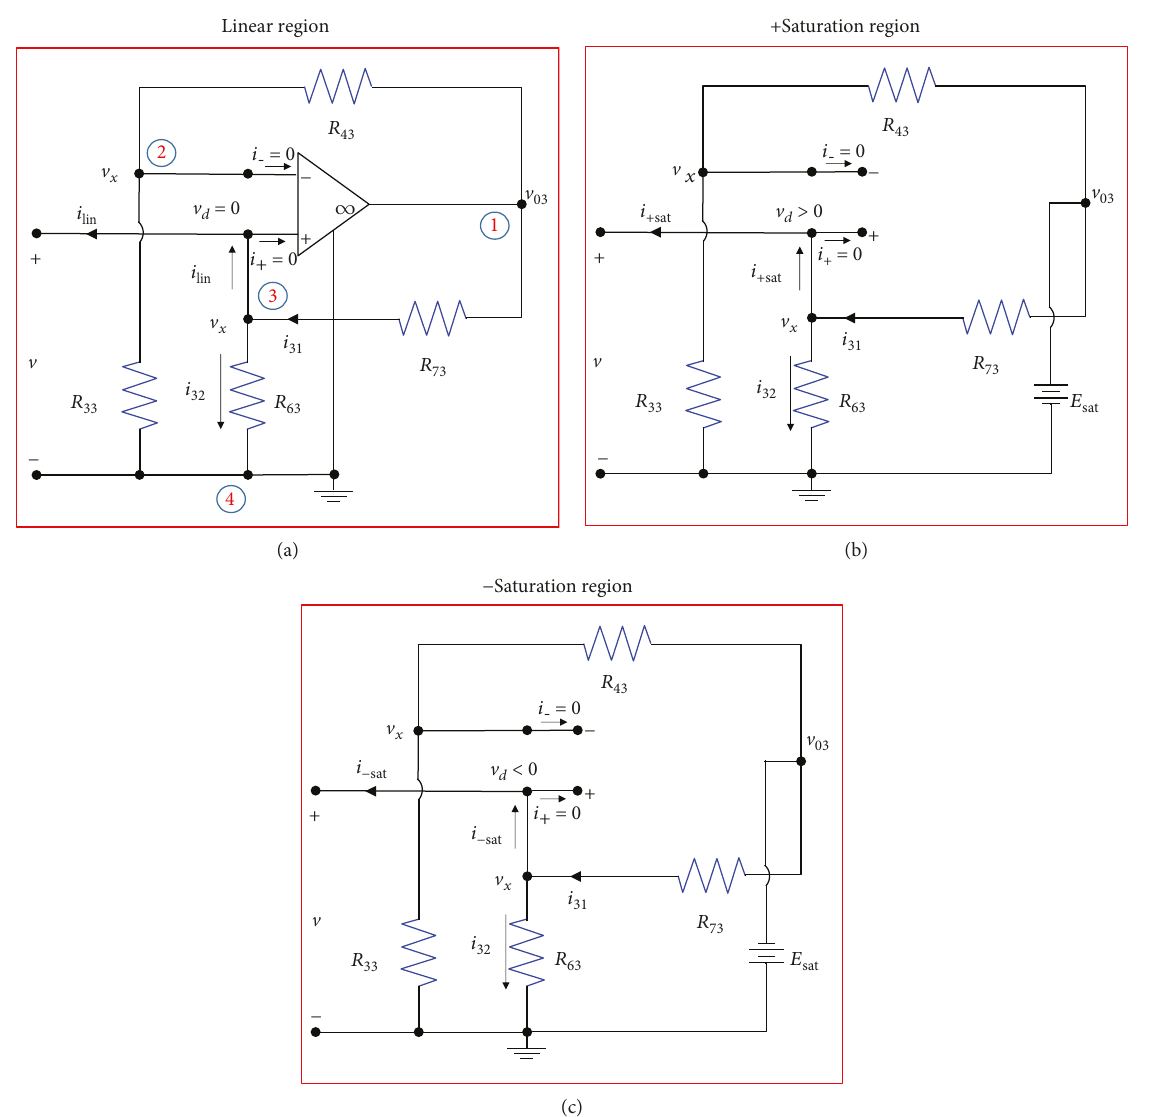
Figure 12: Region-based ideal models of the op-amp circuit: (a) Linear region, (b) +Saturation region, and (c) − Saturation